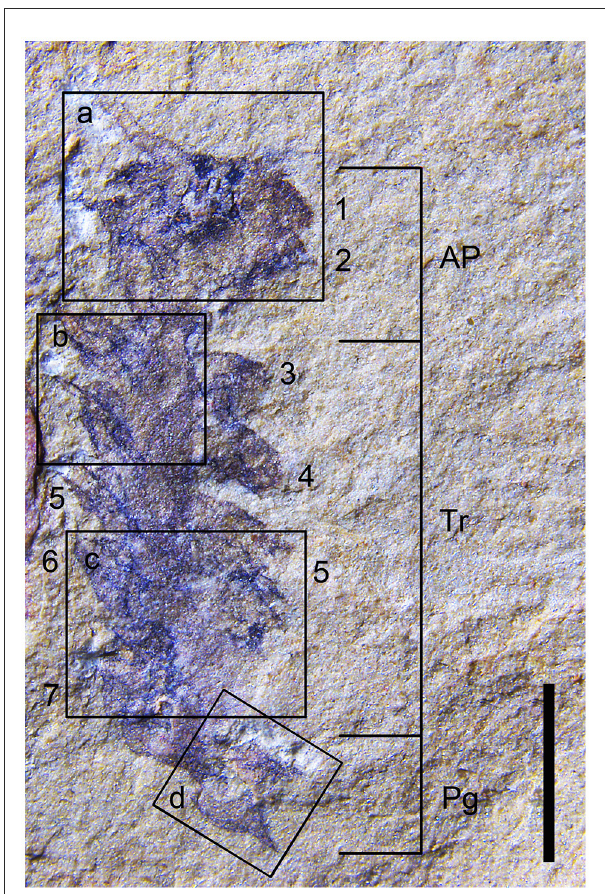
FIGURE2 Gaoloufangchaeta bifurcus gen. et sp. nov. from the early Cambrian Guanshan biota (Yunnan Province, China). AP, anterior part; Pg, pygidium; Tr, trunk. The scale bar is